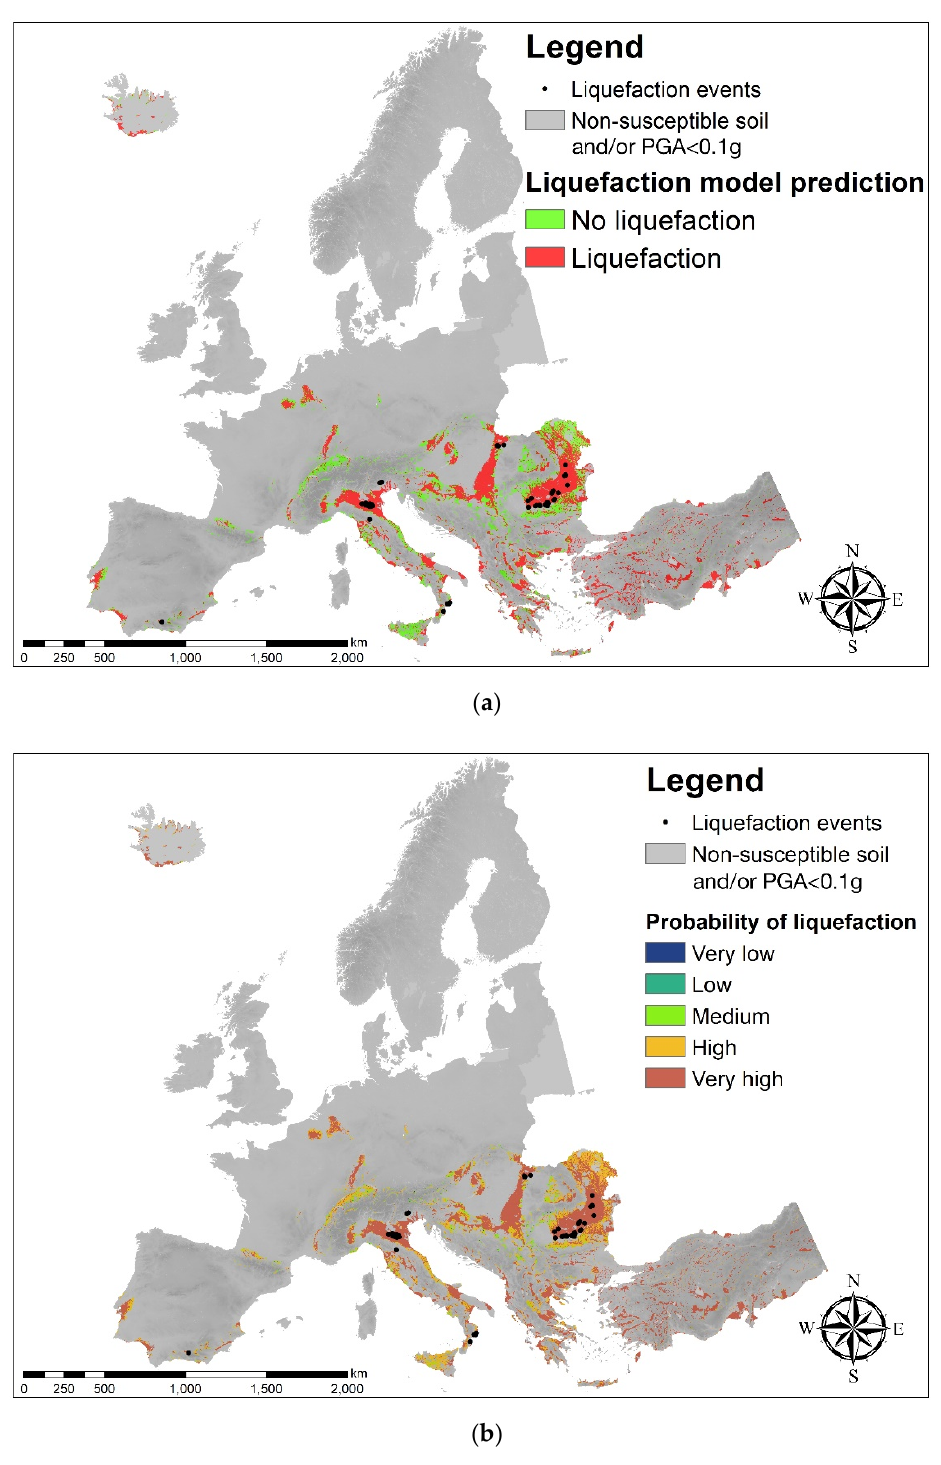
Figure 2. Maps showing the liquefaction potential for the European territory referred to the return period of 475 years [7]. The results are expressed ( a ) as a binary outcome, i.e., liquefaction or no liquefaction, and ( b ) according to a chromatic scale based on five different classes of the probability of liquefaction. Locations of liquefaction occurrences (black dots) associated with a return period of about 475 years are superimposed to both charts. The grey areas are a priori excluded because of either the geological-based or the seismic-hazard based filters herein applied (the greyscale is based on Digital Elevation Model, DEM).